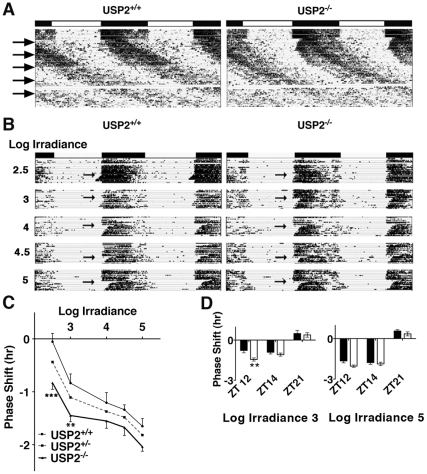
USP2
−/−
 mice are more sensitive than wildtype to low irradiance light at ZT12.
A. Wheel running records from USP2+/+ and USP2−/− mice in constant light. Plots represent the mean activity recorded in USP2+/+ (n = 7) and USP2−/− (n = 8) mice. Mice were initially housed in LD (∼60–120 µW/cm2) and transitioned to LL (top arrow, left) at ZT12 using low irradiance light (∼5–20 µW/cm2). Every 10 days (at each arrow, top to bottom) the irradiance was increased sequentially to 30–60, 50–100, 60–120, and ∼100–160 µW/cm2. The white band between the lower 2 arrows is a period when activity was not recorded due to a computer error. B. Mice were housed in LD for 7 days followed by a 4-hour dim light treatment (Log irradiance 2.5, 0.05 µW/cm2) beginning at the time of light offset and followed by a 7 day free-running period in DD to monitor the resulting phase shift. Mice were returned to LD for 7 days and the experiment was repeated with light of higher irradiance (i.e., Log irradiance 3, 4, 4.5 and 5); Log 5 corresponded to an irradiance of 9 µW/cm2. The plots are the mean activity of 5 mice for each genotype. C. Irradiance response relationship for USP2+/+ (thin line), USP2−/− (thick line), and USP2+/− mice (dashed-line). Phase shifts following each light treatment was compared between USP2+/+ and USP2−/− mice (**p<0.005, ***p<0.001, un-paired t-test). D. Phase shifts measured at Log irradiance 3 and Log irradiance 5 following 4 hours of light at ZT12 (same data as in C) compared to treatments beginning at ZT14 and ZT21 for USP2+/+ (black bars) and USP2−/− (white bars) mice. Significant differences (p>0.05) between genotype were not detected at ZT14 or ZT21.